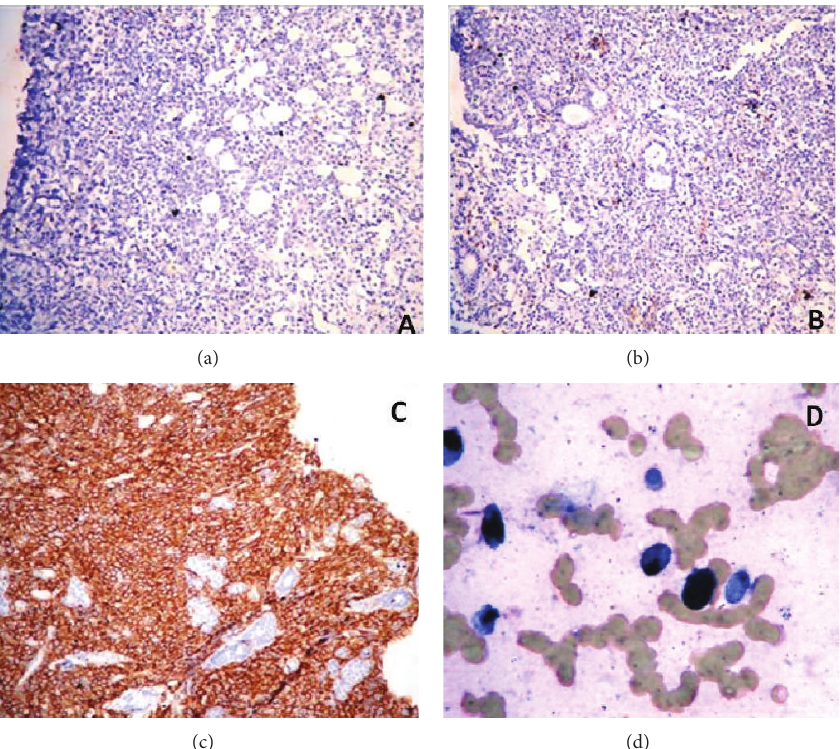
Figure 4: Immunohistochemistry showed (a) S100 negative which ruled out LCH. (b) CD3 negative ruled out T-cell lymphoma. (c) CD43 positive in all neoplastic cells. (d) Myeloblasts are demonstrated in PBS by myeloperoxidase